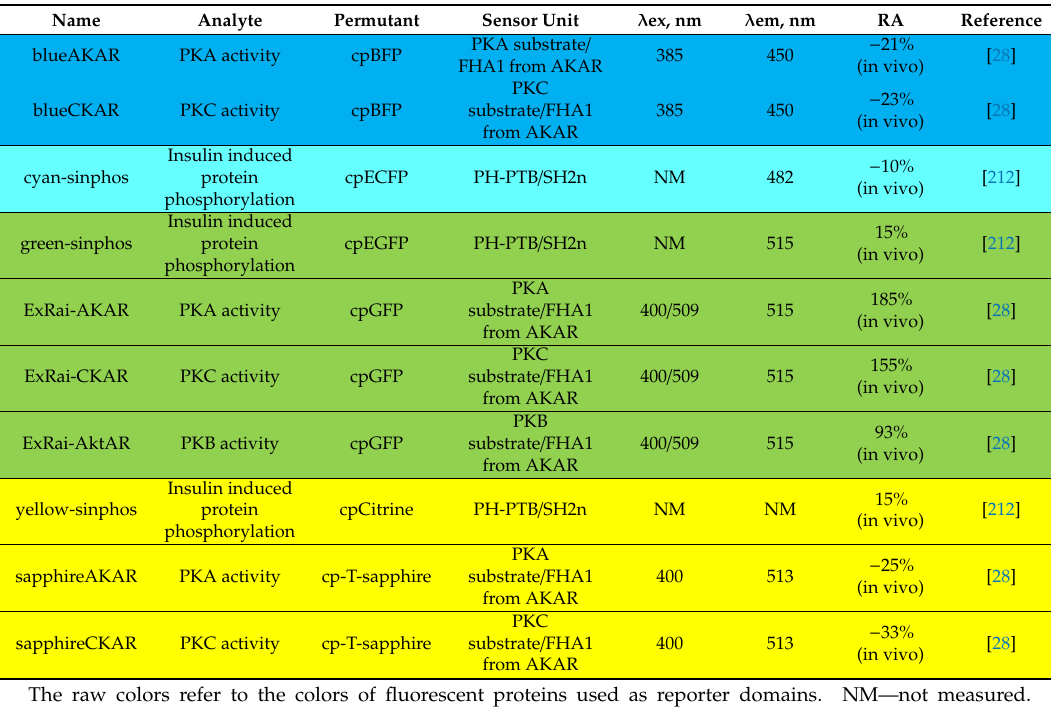
Table 7. GEFIs for measuring kinase